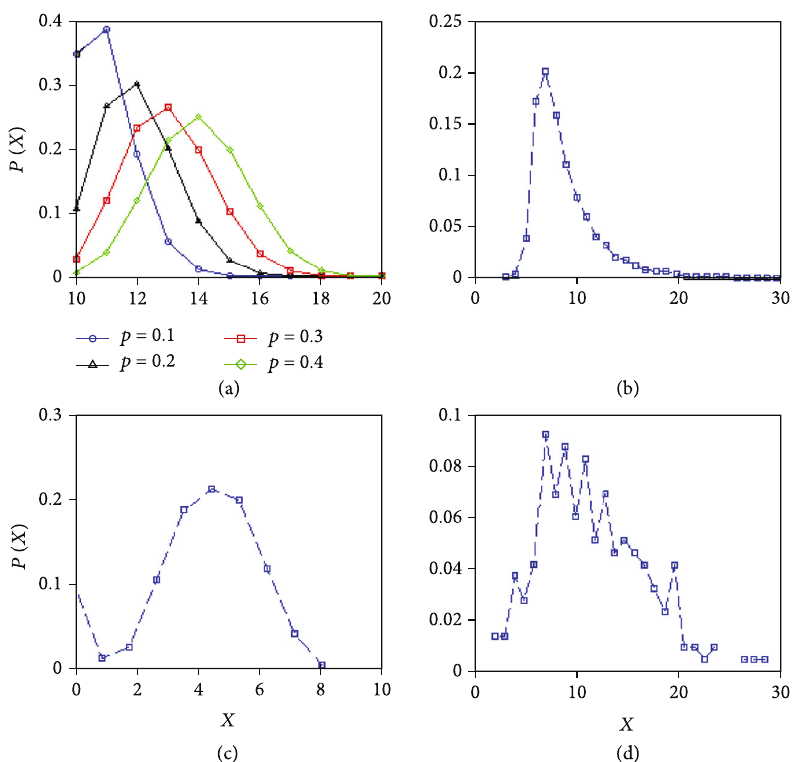
Figure 2: The initial degree distribution of new nodes: (a) model result ( m = 10 ); (b) data from the online dictionary entry hyperlink network [45]; (c) physicians trust network [46]; (d) student interpersonal network